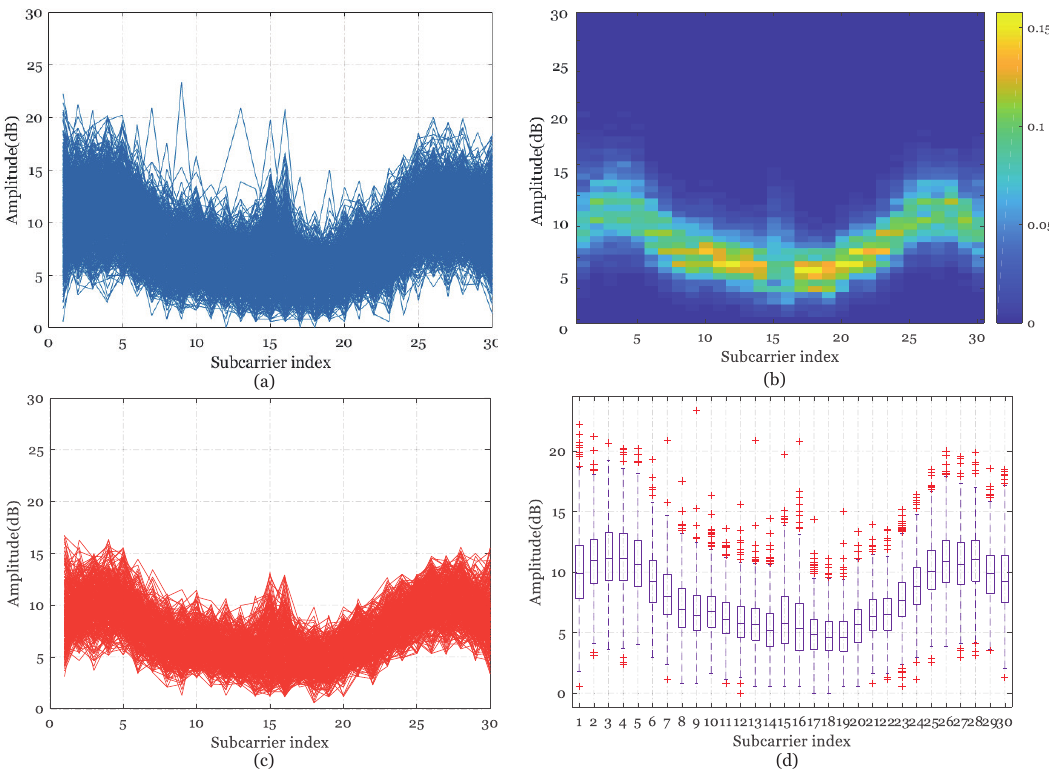
Figure 4. CSI amplitude outlier filtering processing in scenario 4 (Complex garage). ( a ) Raw CSI amplitude at position 4. ( b ) The distribution heat map of the amplitude probability at position 4.